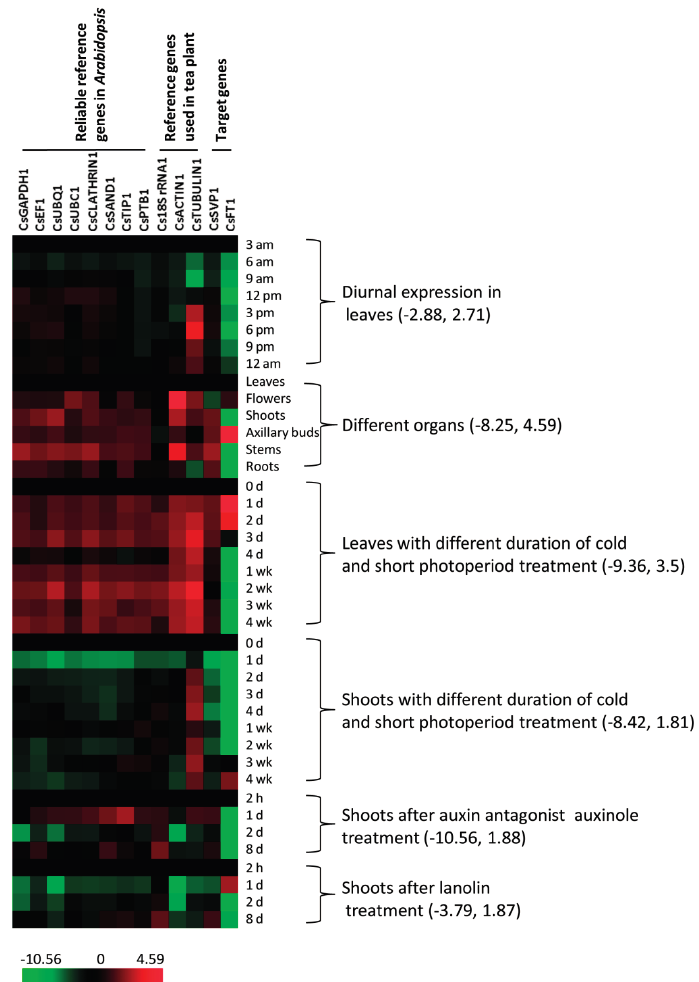
Figure 2. Expression profile of candidate reference genes and target genes under different experimental conditions. Six experimental series including 94 samples were used to examine gene expression. The fold difference is designated as log2 value. Red indicates up-regulated genes and green indicates down-regulated genes as compared with first sampling point/tissue. Bars at the bottom indicate the range of transcript changes in log2 value. The range of transcript changes for each experimental series is provided inside the